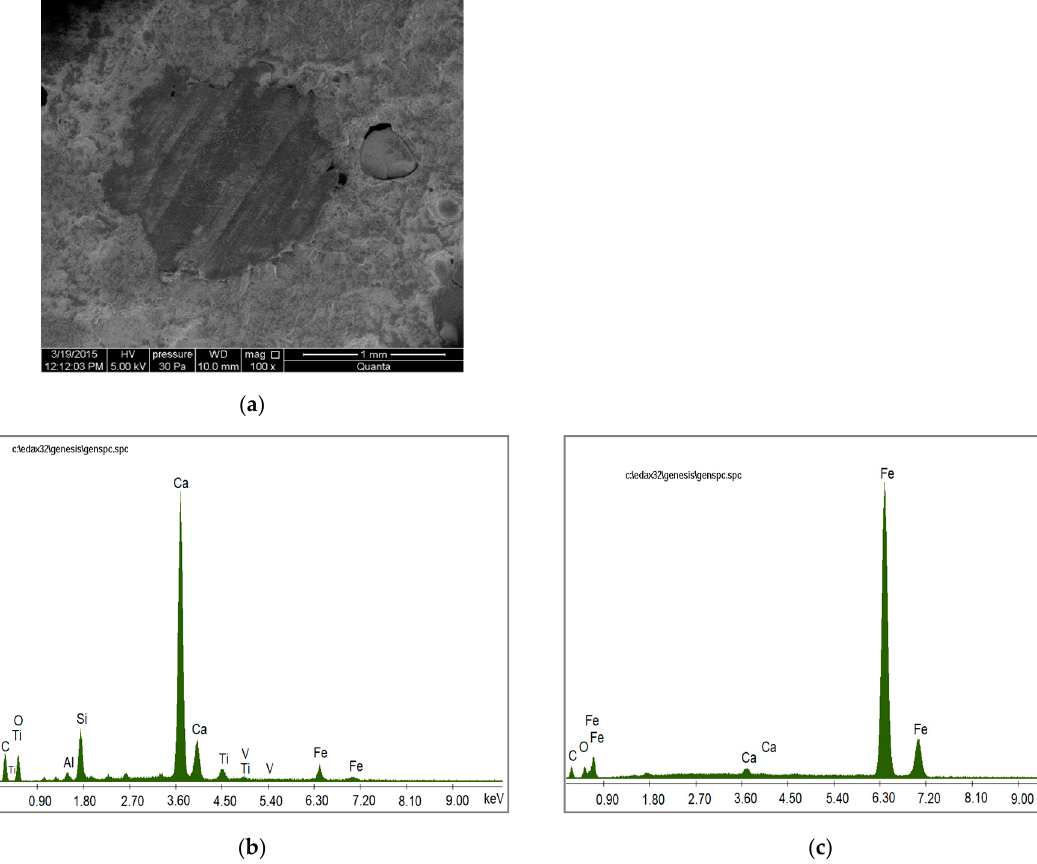
Figure 13. Microstructure of the steel fiber-reinforced concrete (SFRC) specimen with EDS analysis: ( a ) the scanning microscope image of the concrete sample with the visible fiber section; ( b ) EDS analysis of the concrete; ( c ) EDS analysis of the fiber.